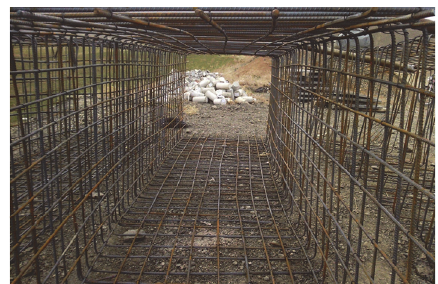
Figure 1: Mesh network inside the RC